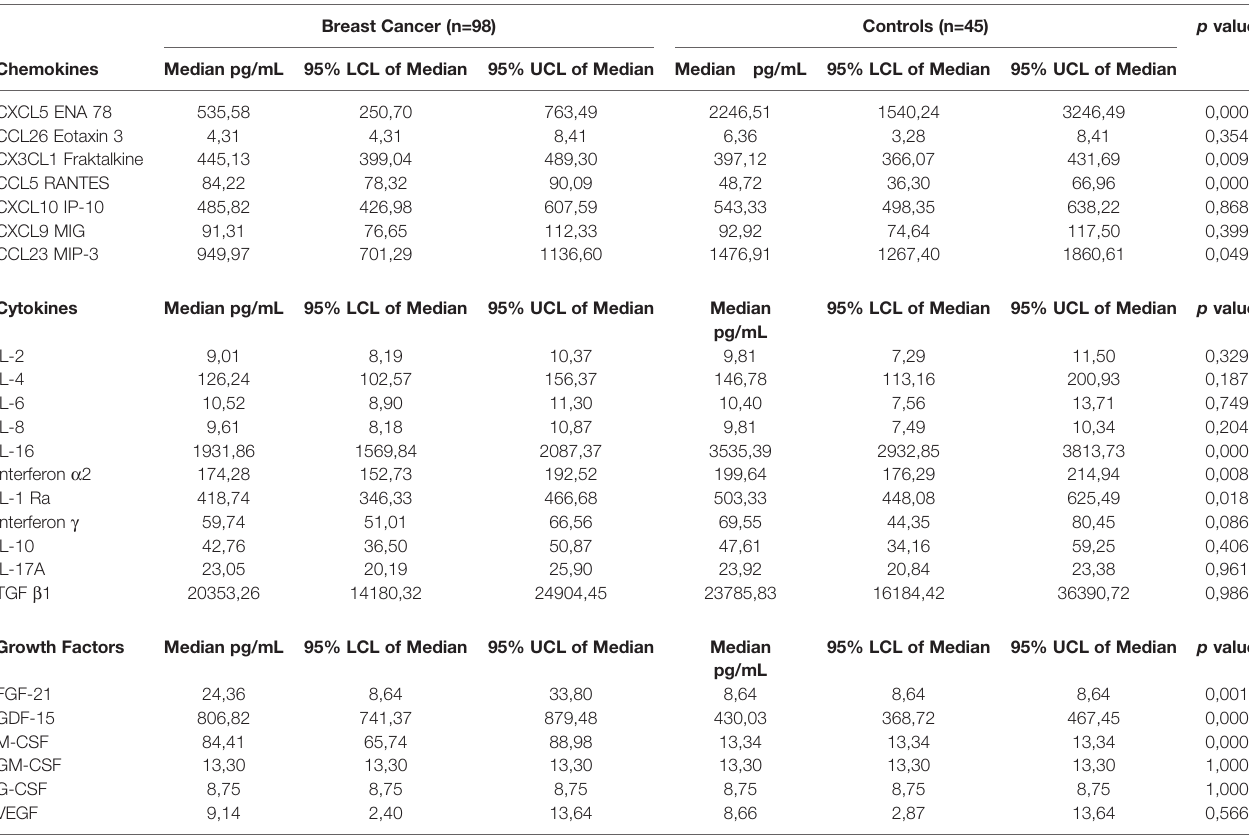
TABLE 3 | Comparison of plasma concentrations of cytokines, chemokines and growth factors between newly diagnosed breast cancer patients and control subjects. Breast Cancer (n=98) Controls (n=45) p value Chemokines